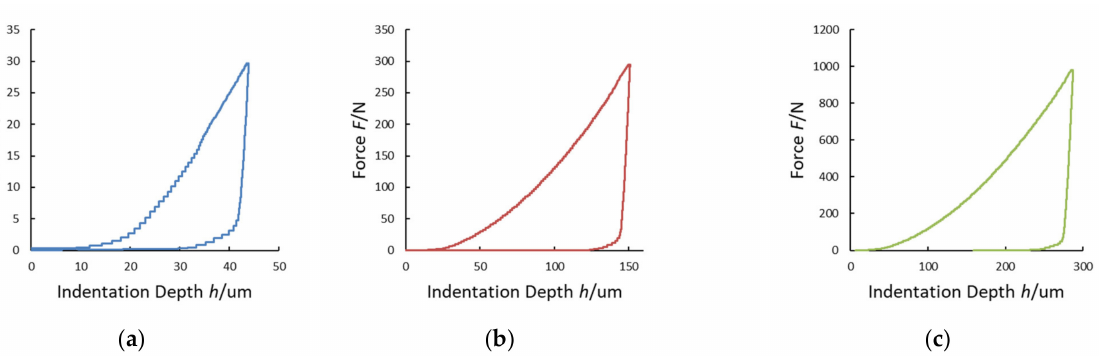
Figure 10. Loading–unloading curves of the HV tests on Cu–Cr–Zr alloy: ( a ) HV3; ( b ) HV30; ( c )